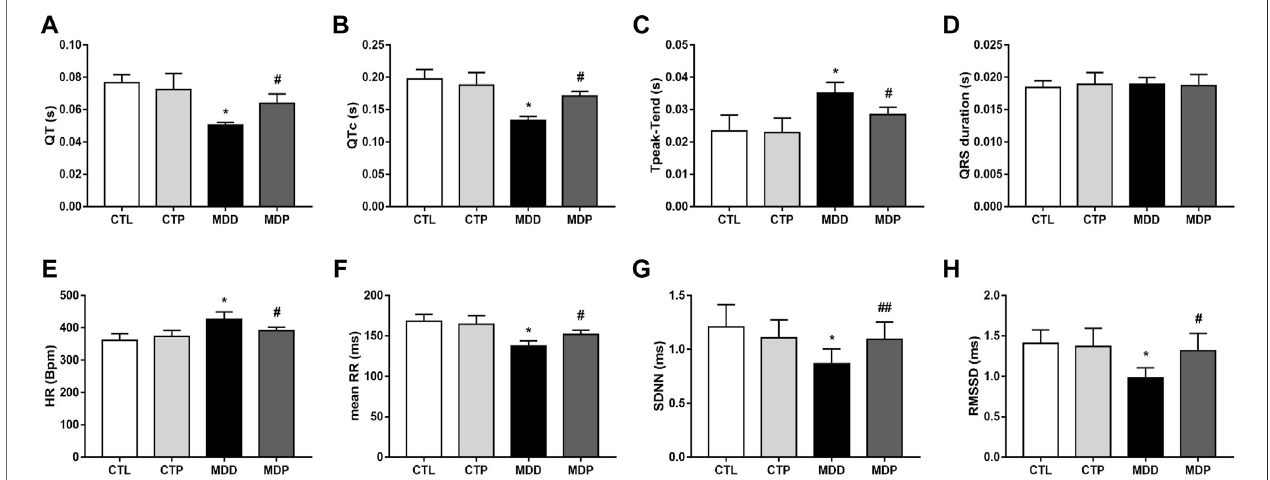
FIGURE6| ElectrocardiogramparametersandHRV. (A – D) QTinterval,correctedQTinterval,Tpeak – TendintervalandQRSinterval,respectively.n (cid:1) 7pergroup. (E – H) StatisticalanalysisofHR,meanRR,SDNN,andRMSSD,respectively.n (cid:1) 7pergroup.* p < 0.01vs.CTL;# p < 0.01vs.MDD;## p < 0.05vs.MDD.HRV,heartrate